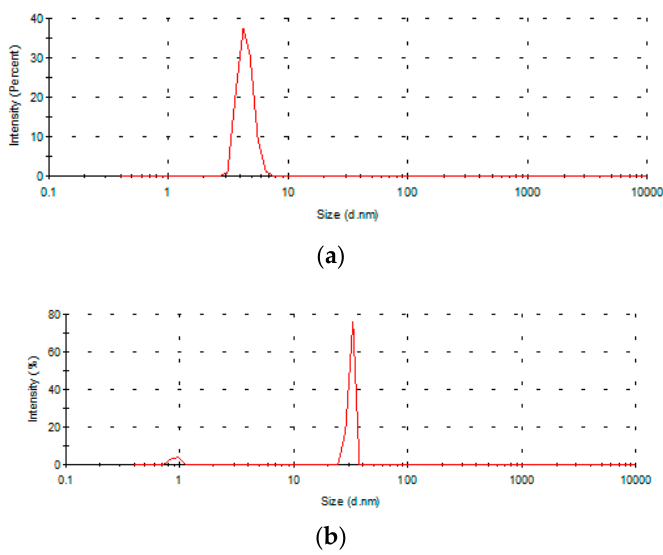
Figure 11. Particle size distribution of the chitosan ( a ) and chitosan/tea tree oil ( b ) emulsions in diluted acetic acid containing surfactant Tween 80. Table 7. DLS results for essential oil/chitosan emulsions used to obtain films for food packaging. Sample